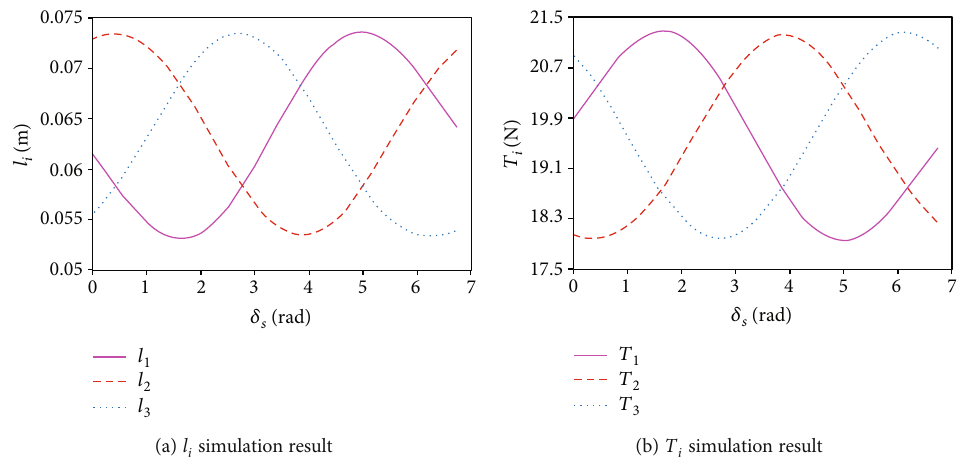
Figure 12: Curves of the rope length and tension when δ